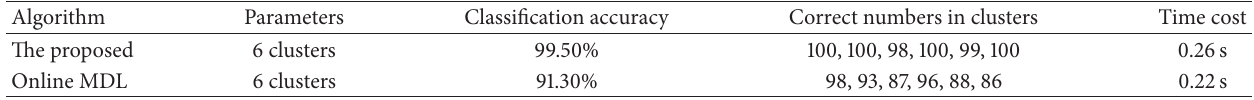
Table 8: Performance results for 600